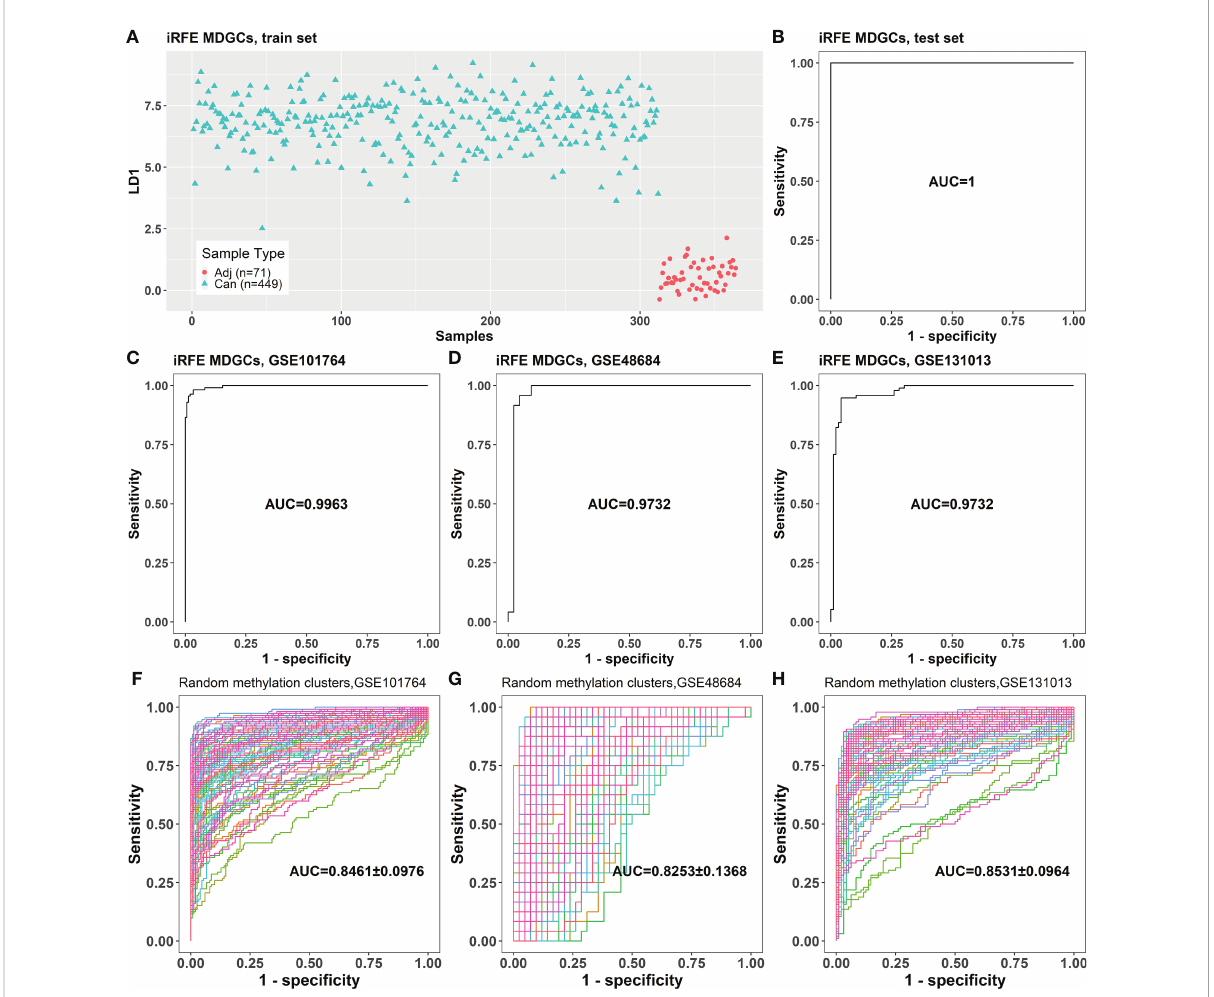
FIGURE 3 The classi fi cation performance of the LDA model based on the four iRFE MDGs. (A) The LDA model established with the samples in the train set. (B) The classi fi cation performance of the LDA model on the test set. (C – E) The classi fi cation performances of the LDA model for cancer and cancer-adjacent samples from GSE101764, GSE48684, and GSE131013. (F – H) The classi fi cation performances of the LDA models based on randomly selected four genes from MDGs on GSE101764, GSE48684, and GSE131013 datasets (100 repeats). Adj, cancer-adjacent tissues; Can, cancer tissues; LDA, linear discriminant analysis; iRFE, iterative recursive feature elimination; MDGs, methylation-driven